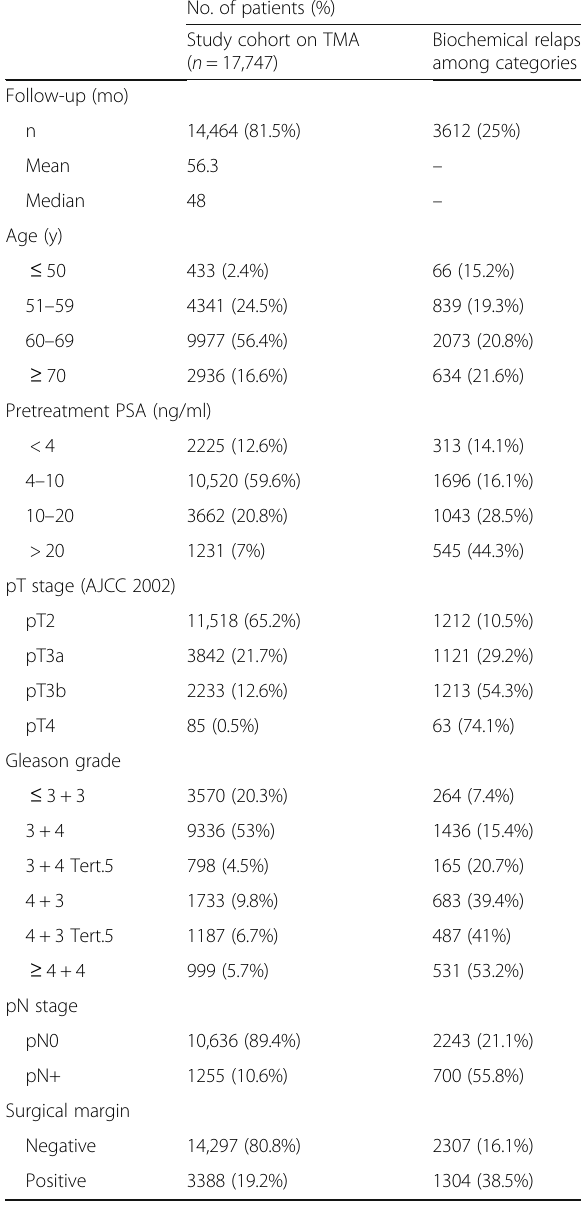
Table 1 Composition of the prostate prognosis tissue microarray. Percentage in the column “ Study cohort on TMA ” refers to the fraction of samples across each category. Percentage in column “ Biochemical relapse among categories ” refers to the fraction of samples with biochemical relapse within each parameter in the different